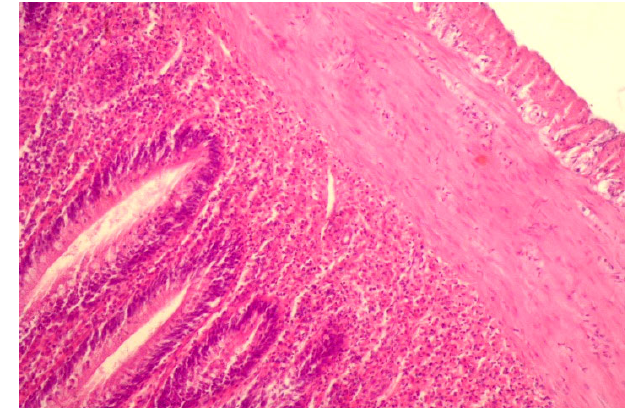
Fig. 9. Thickening of the submucosal and muscular layer of the intestine with focal cell infiltration and crypt elongation in Experiment 3. H&E. x